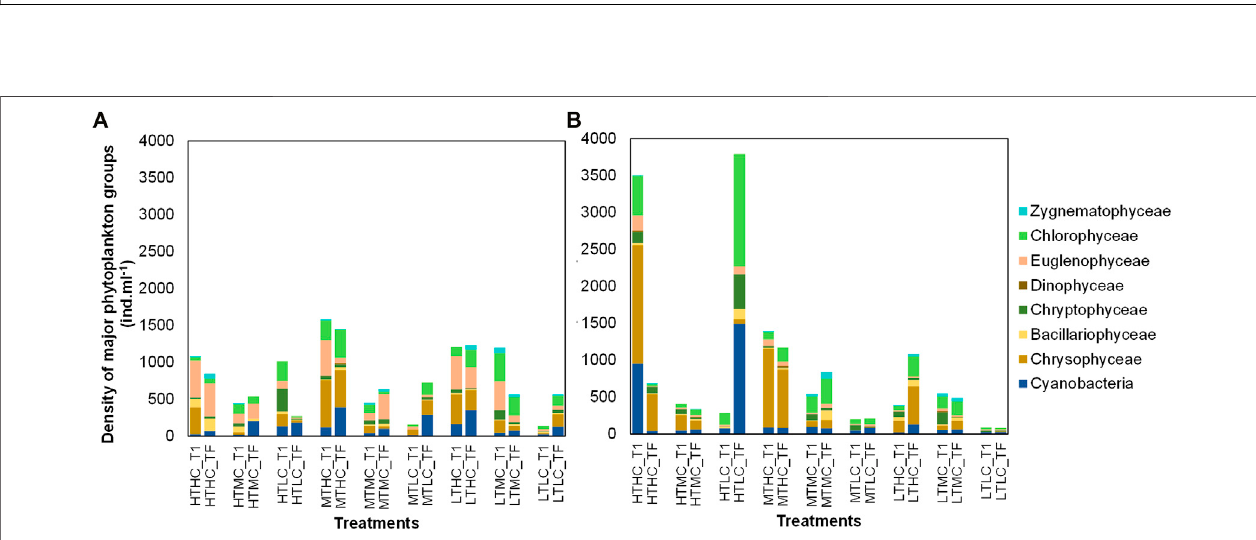
FIGURE5| Density(ind/mL)ofmainphytoplanktongroupsbysedimentandbytreatmentattheinitialtime(T1)and fi naltime(TF). (A) ,NBresults; (B) ,IBresults.NB meansNaturalBatataandIBmeansImpactedBatata.HT:HighTurbidity; MT:MediumTurbidity;LT:LowTurbidity;HC:HighChlorophyll;MC:Medium Chlorophyll;LC: Low